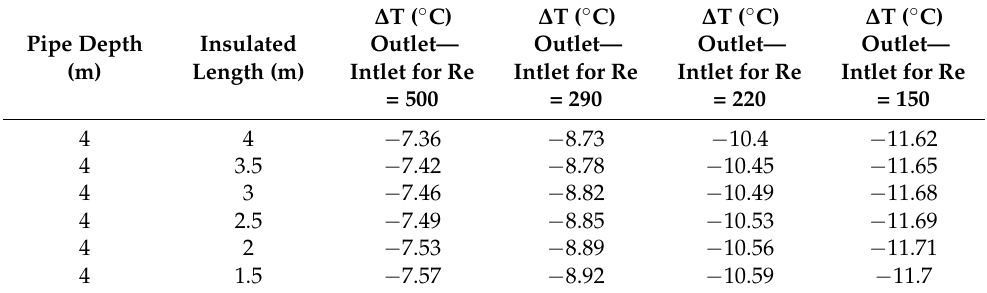
Table 15. Results of the cooling potential according to the isolated length of the GAHE outlet pipe.